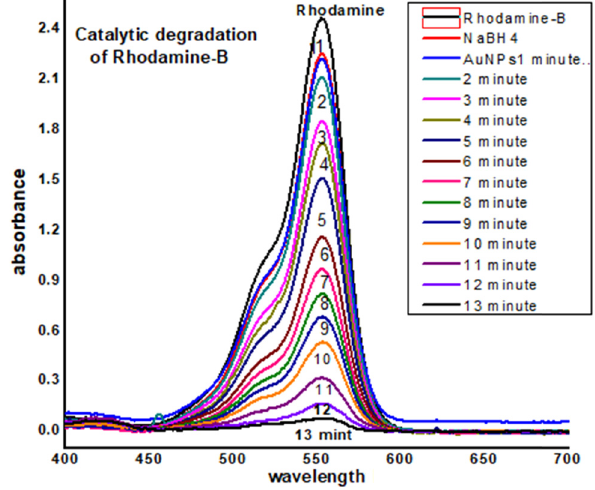
Figure 17: UV - Visible data of catalytic degradation of Rhodamine B.